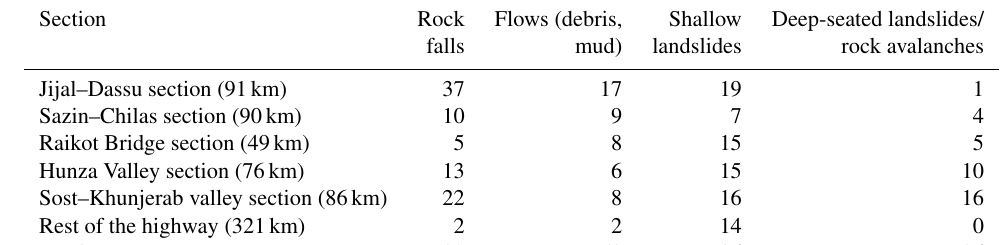
Table 6. Types of landslides along the KKH.